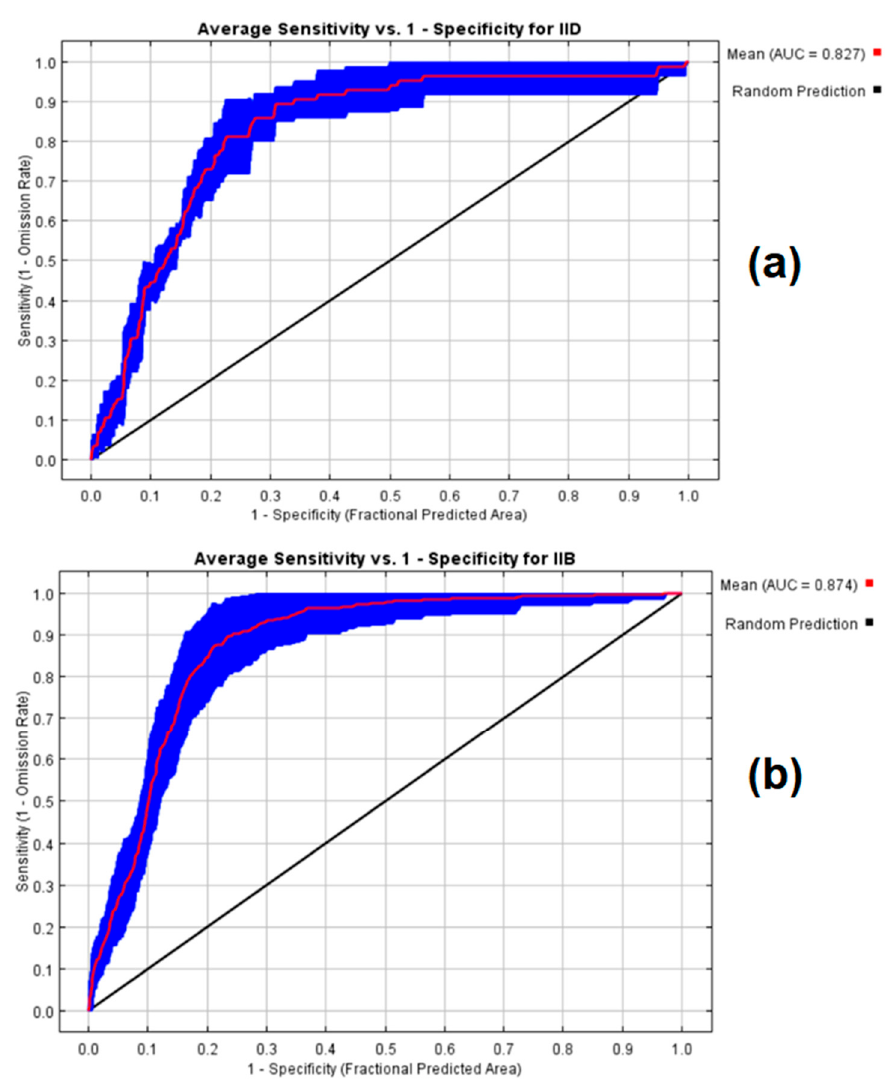
Figure 2. The ROC curve for II-D & II-B showing the AUC for ( a ) Alfalfa (16SrII-D) and ( b ) lime (16SrII-B). The envelope around the mean AUC (plus/minus one standard deviation) is shown in blue color. For 16SrII-D phytoplasma, the seven bioclimatic variables that were influential in the spatial distribution of phytoplasmas in Alfalfa were isothermality (bio3, contributed 29.7%), mean diurnal range (bio2, contributed 25.6%), seasonal precipitation (bio15, contributed 13.1%), mean temperature of the wettest quarter (bio8, contributed 10.1%), precipitation in the warmest quarter (bio18, contributed 7%), precipitation in the driest month (bio14, contributed 5.6%), and topography (DEM, contributed 5.6%).